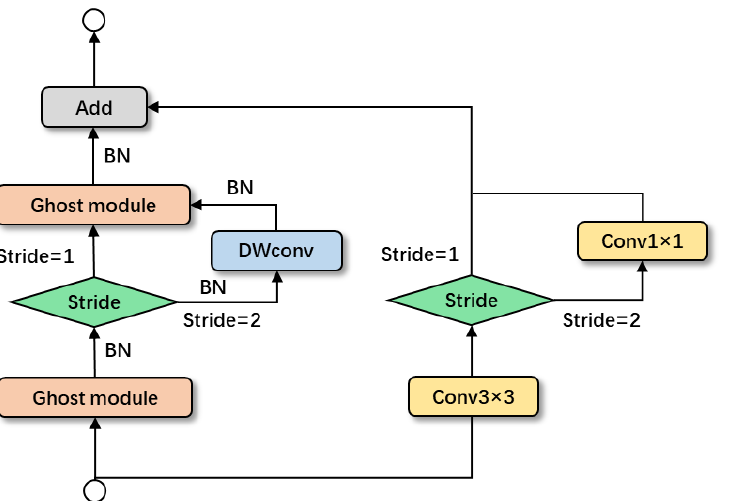
Figure 5. Improved Ghost bottleneck structure. If stride = 1, the two Ghost modules are directly connected, and a 3 × 3 convolution block is used by shortcut. If Stride = 2, the two Ghost modules are connected by depthwise convolution, and a 3 × 3 convolution block and a 1 × 1 convolution block are added in the